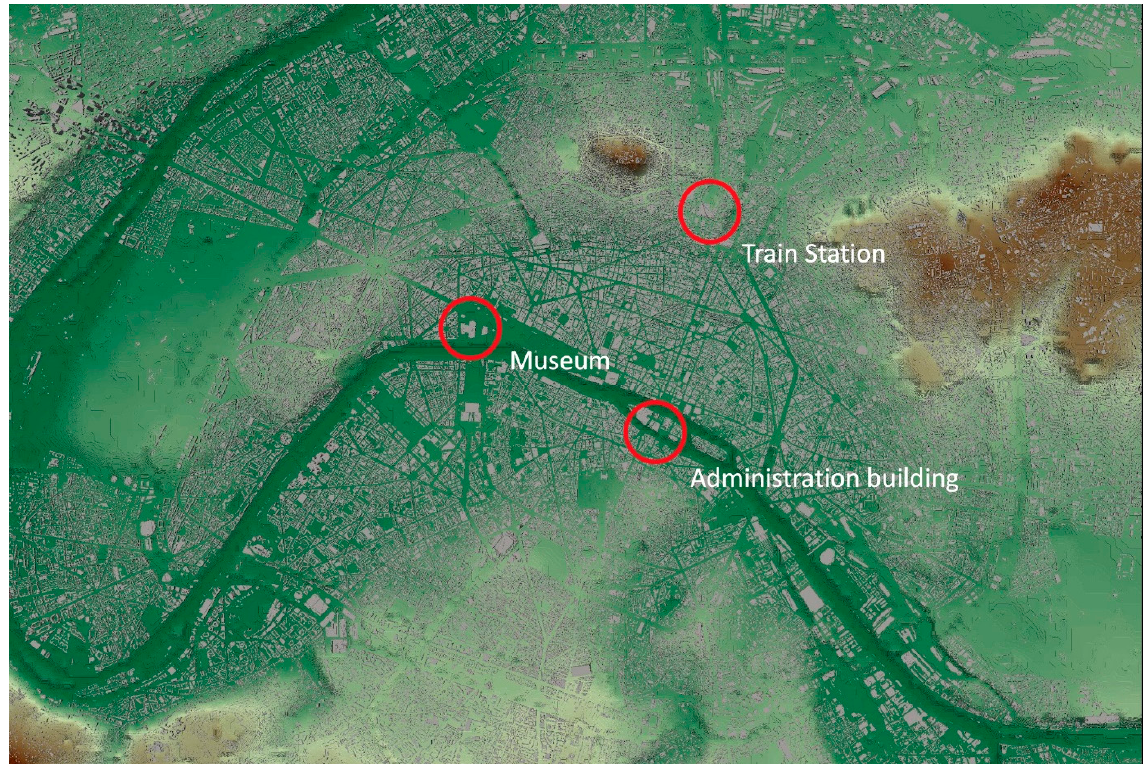
Table 1. Nested domain main characteristics.